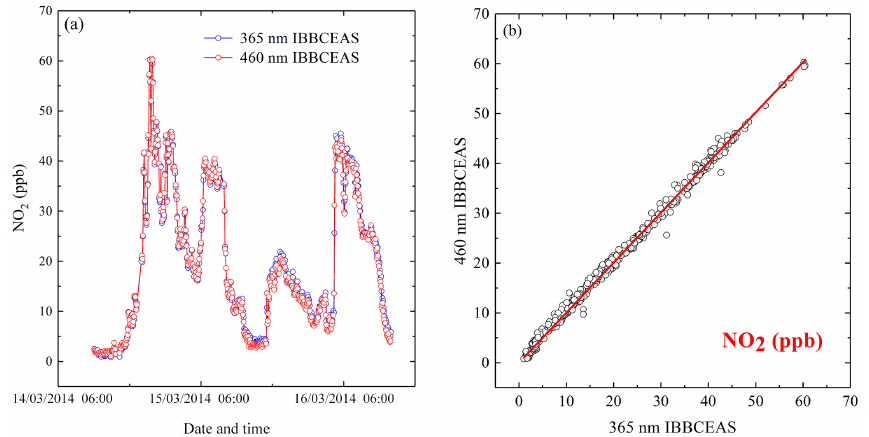
Figure 4. (a) Time series measurements of NO 2 from the 365nm IBBCEAS and 460nm IBBCEAS. (b) Correlation plot of between the two NO 2 measurements.